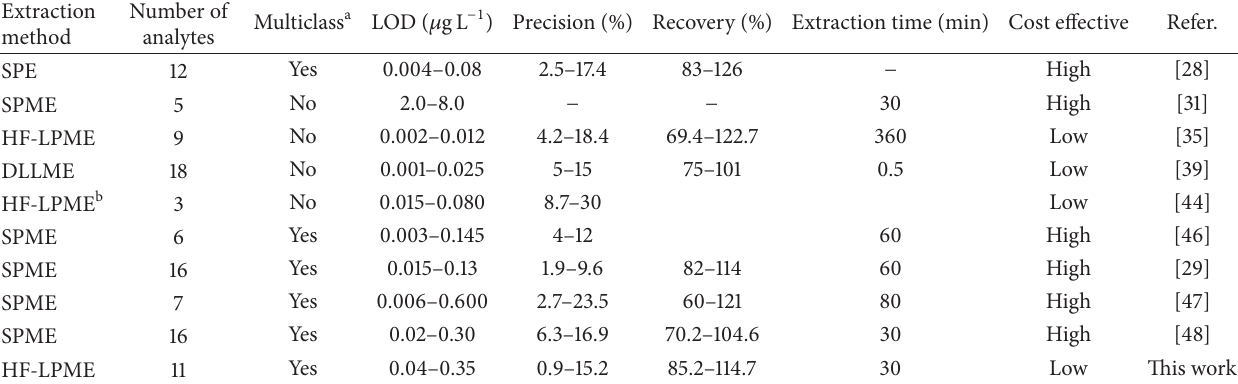
Table 3: Comparative study for some parameters of HF-LPME-GC/MS developed method with other related methods. Extraction